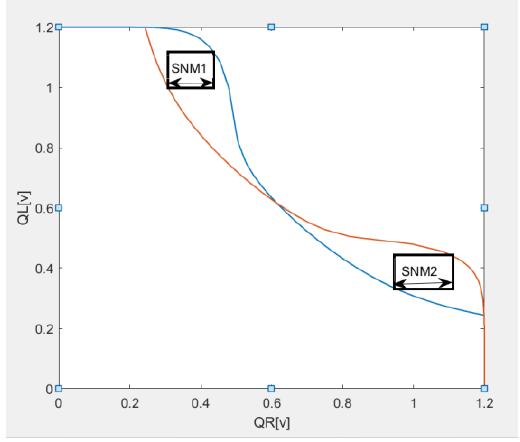
Figure 3. Static stability simulation curve of reading operation.